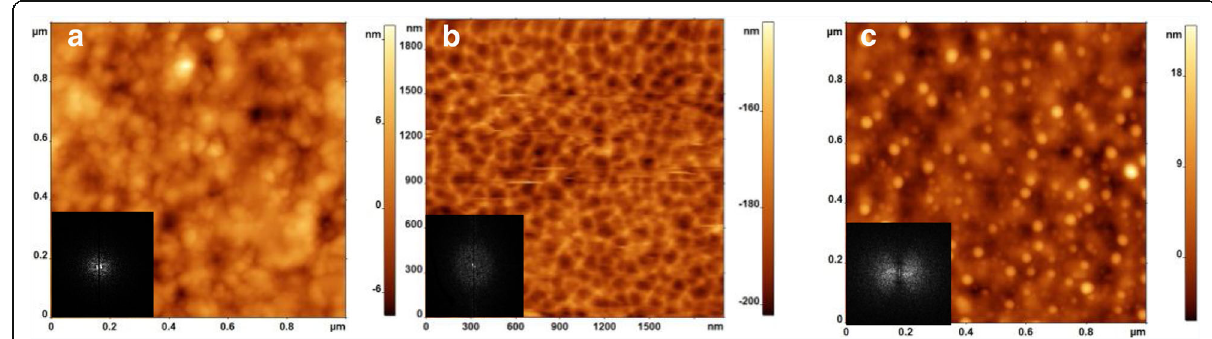
Fig. 1 AFM images of a (111) MCT surface generated as a result of the ion bombardment with B + and Ag + ions. a Typical virgin surface. b B + ( θ = 0°, 100 keV, 3 × 10 13 cm − 2 ). c Ag + ( θ = 0°, 100 keV, 3 × 10 13 cm − 2 ). Inset : Fourier transforms of AFM